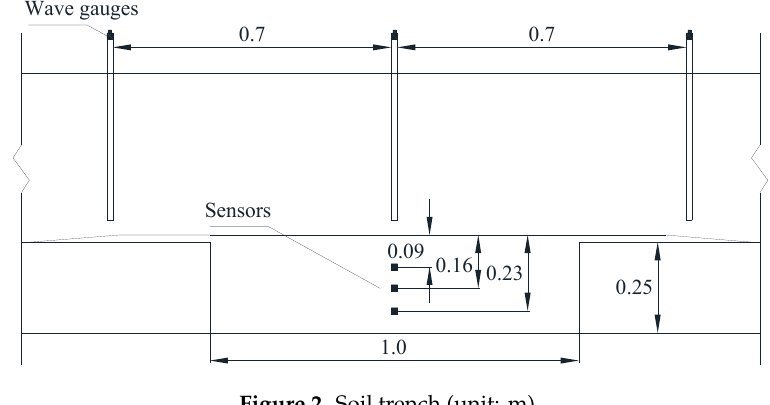
Figure 2. Soil trench (unit: m).